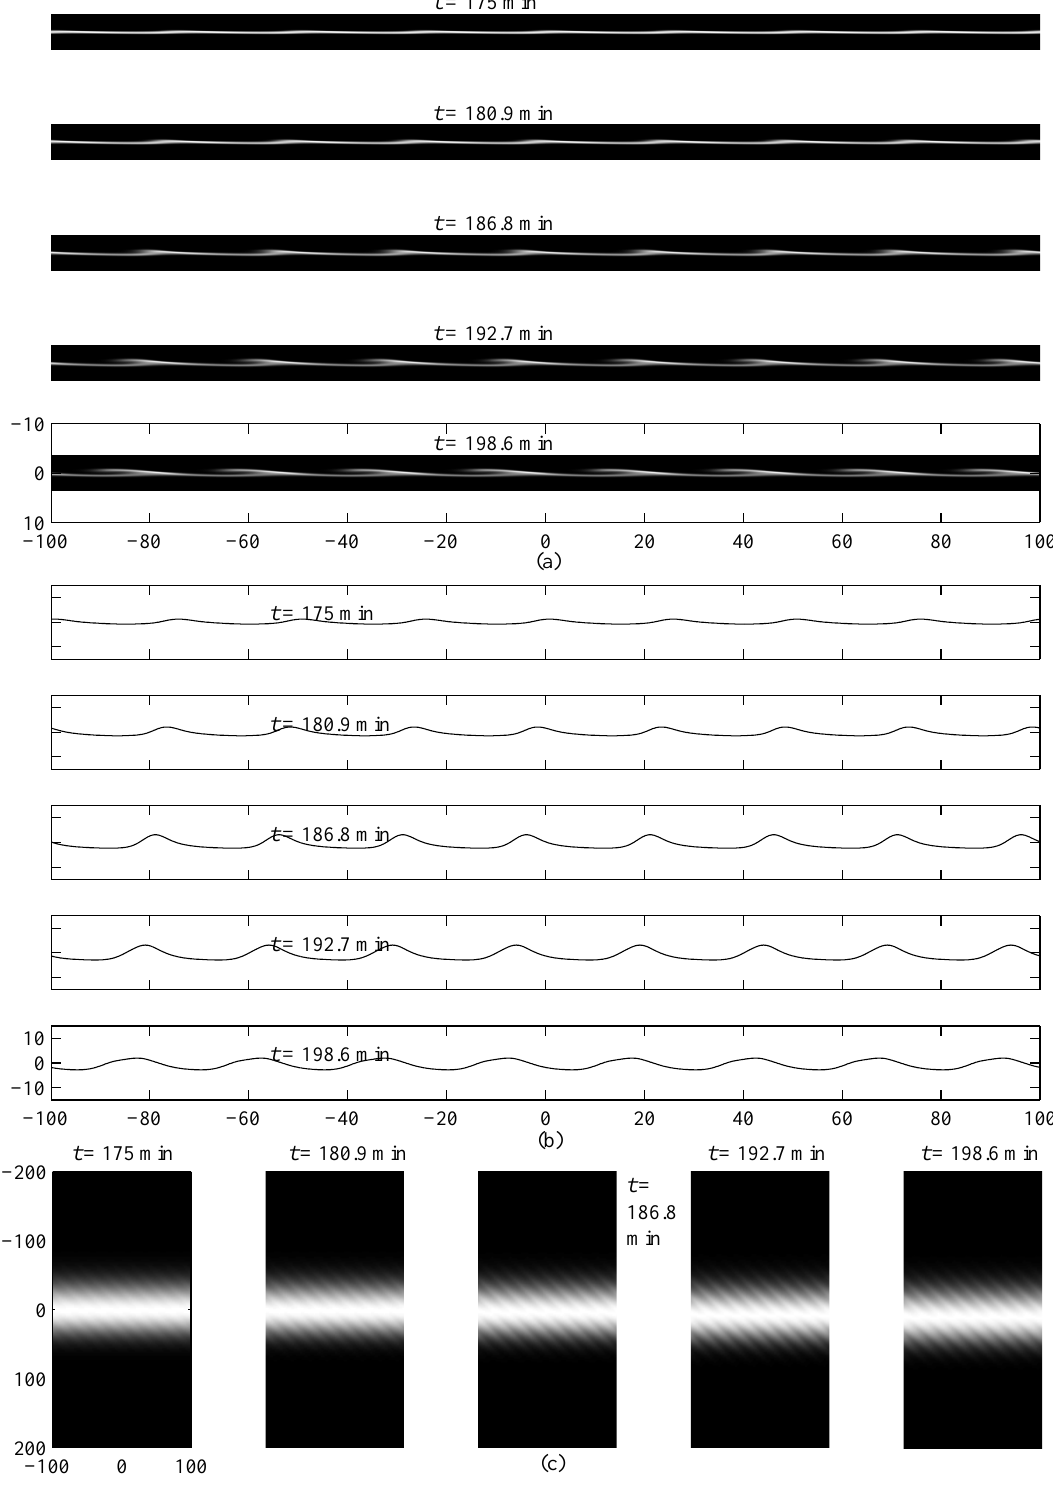
Figure 5: Seed wavelength of 25 km with Σ H Σ = 1 . 8. (a) E s layer, (b) electric field, and (c) F layer. The axes for all = 1 . 8. (a) E s layer, (b) electric field, and (c) F layer. The axes for all figures are described in Fig. 5. Seed wavelength of 25km with 6 H PF 6 PF figures are described in Section 2.2, and summarized in Figure 1. Sect. 2.2, and summarized in Fig.